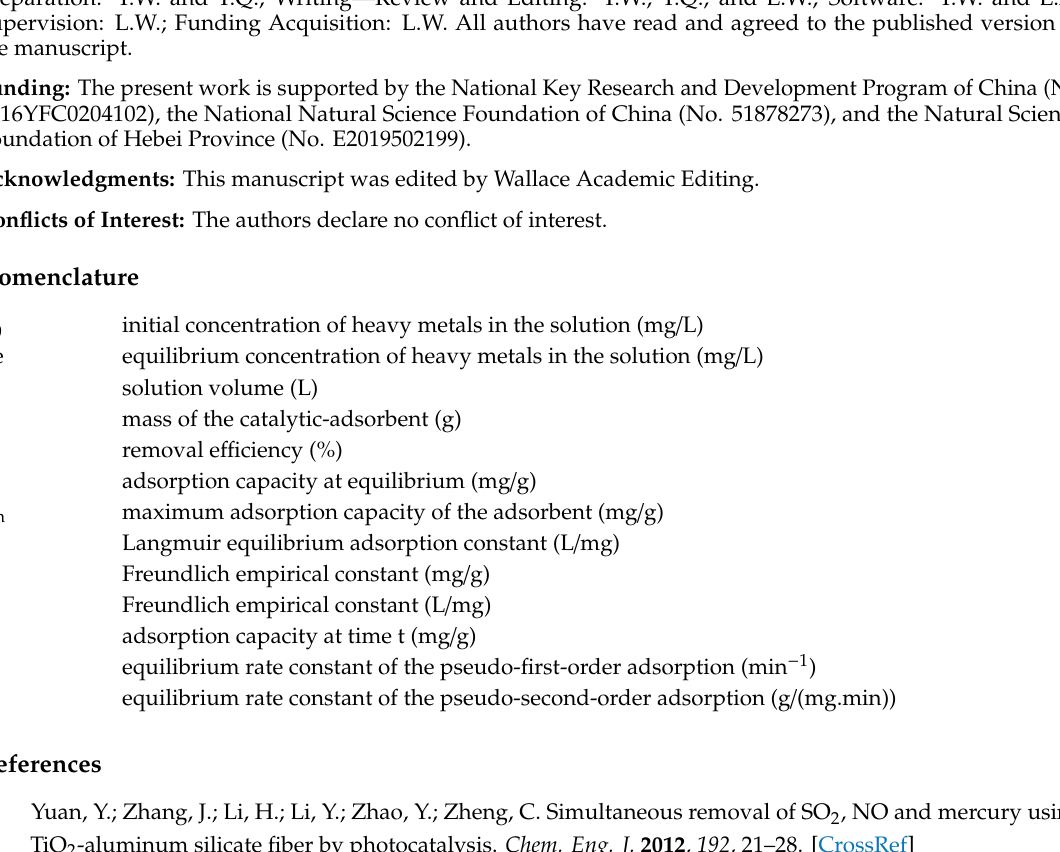
Figure S1: XPS spectrum of 40% Co-ACFs; Figure S2: Catalysis performance of Co-ACFs after four cycles; Figure S3: Comparison of the catalysis activity of Co based catalysts on magnesium sulfite oxidation at a concentration of 0.5 g / L. Table S1: Comparison of adsorption capacities for heavy metals onto di ff erent